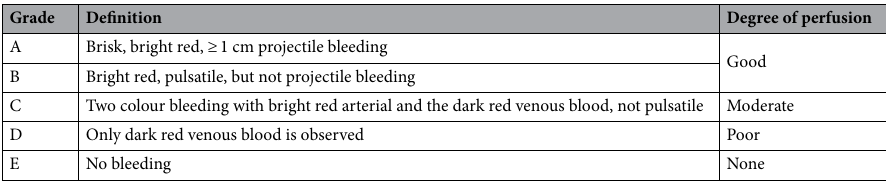
Table 1. Visual grading system to assess the marginal vessel